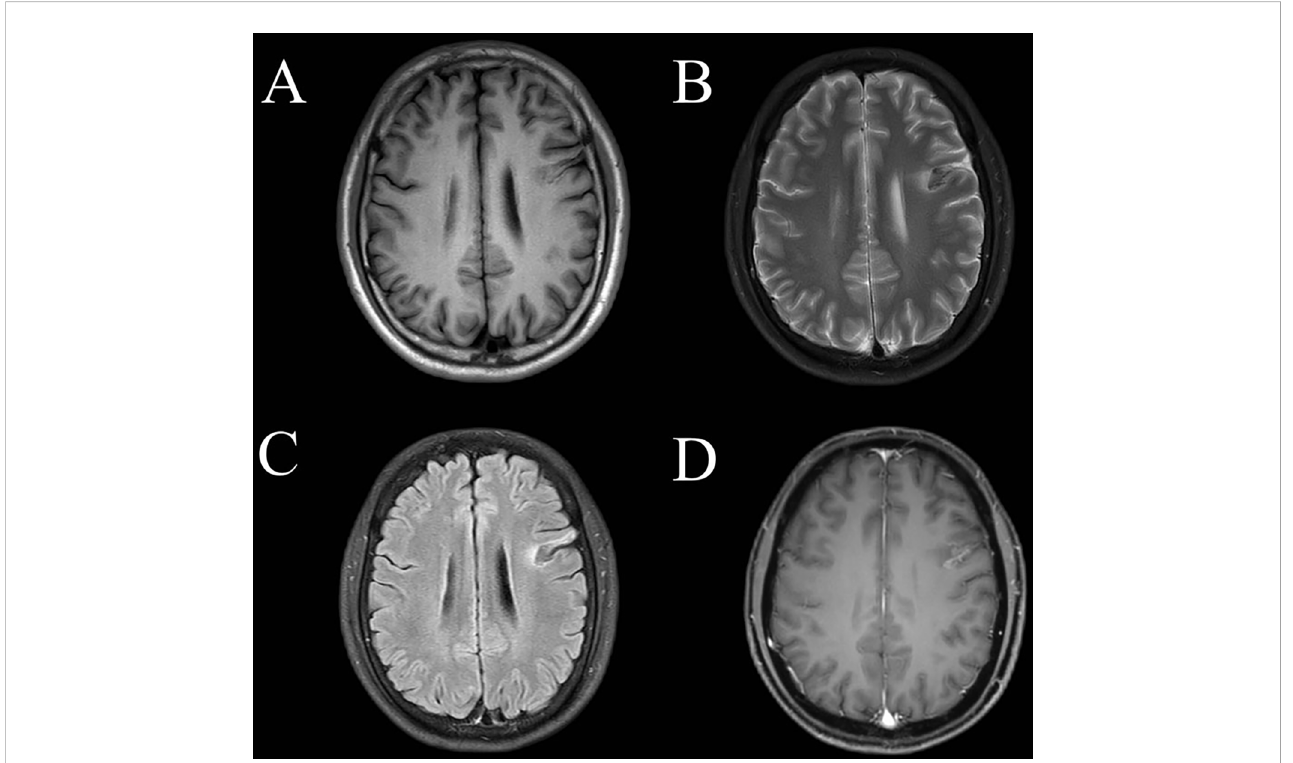
FIGURE 2 Magnetic resonance imaging of the brain one month after immunotherapy. The left frontal lobe showed abnormal (A) T1 hypointensity, high-low mixed sign on T2 imaging (B) and on fl uid-attenuated inversion recovery imaging (C) . (D) This lesion showed gyral and patchy enhancement involving the cortex and subcortical white matter.